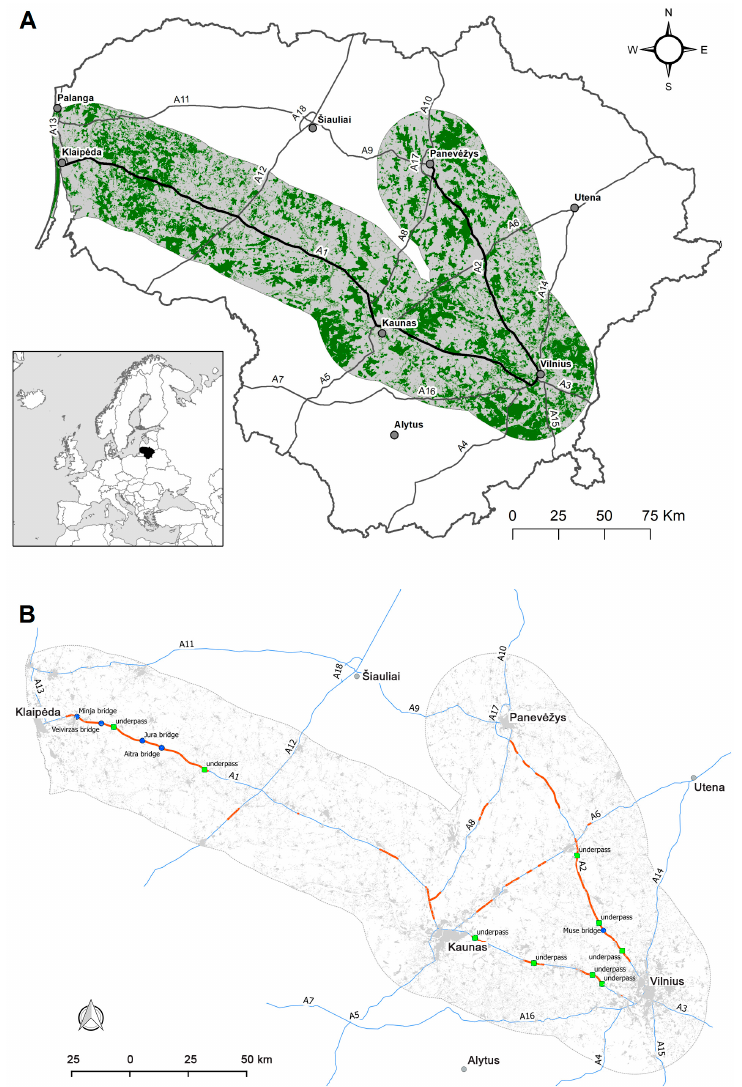
Figure 1. Study area: Map of highways A1 and A2 in Lithuania ( A ): The shaded area shows the 30 km bu ff er either side of the highways. The green color represents forests. Wildlife highway fencing and crossing structures on the highways within the study area, as used in the “current fencing” model are shown, including ( B ) fencing (red lines), underpasses (green squares), and bridges (blue dots), which are all as of 2013. Fencing on the A16 is not shown. River bridges with dimensions (span and height) that might allow cross-highway movement of moose are also shown. The map was created in QGIS, version 2.8 “Wien” (http: // www.qgis.org / ), licensed under the GNU General Public License, using background data from the Lithuanian Asset Information System (http: // lakis.lakd.lt / lakis /